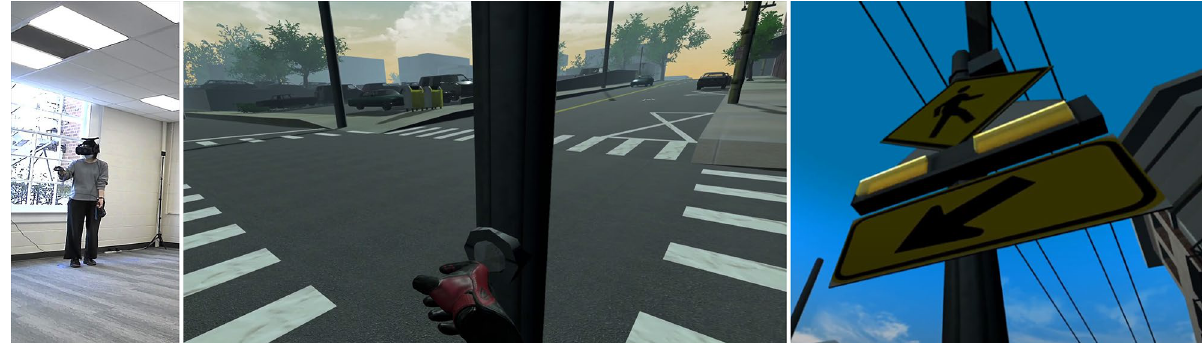
Figure 5. A pedestrian is using a flashing beacon for crossing (left), the pedestrian point of view in IVE (middle), the flashing beacon in IVE (right). A sample video is available in the following link https:// youtu. be/ hz64m